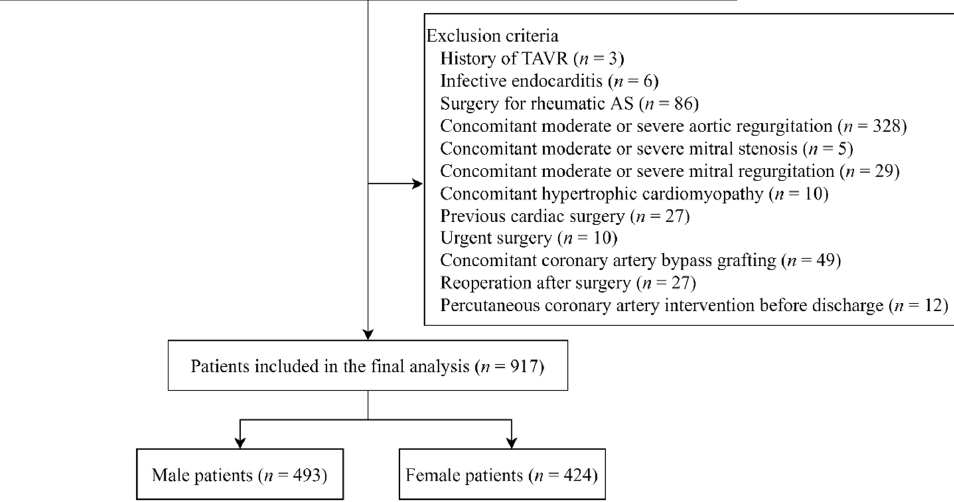
Figure 1. Study population flow chart. SAVR, surgical aortic valve replacement; AS, aortic stenosis; TAVR, transcatheter aortic valve replacement. Table 1. Baseline characteristics according to sex .